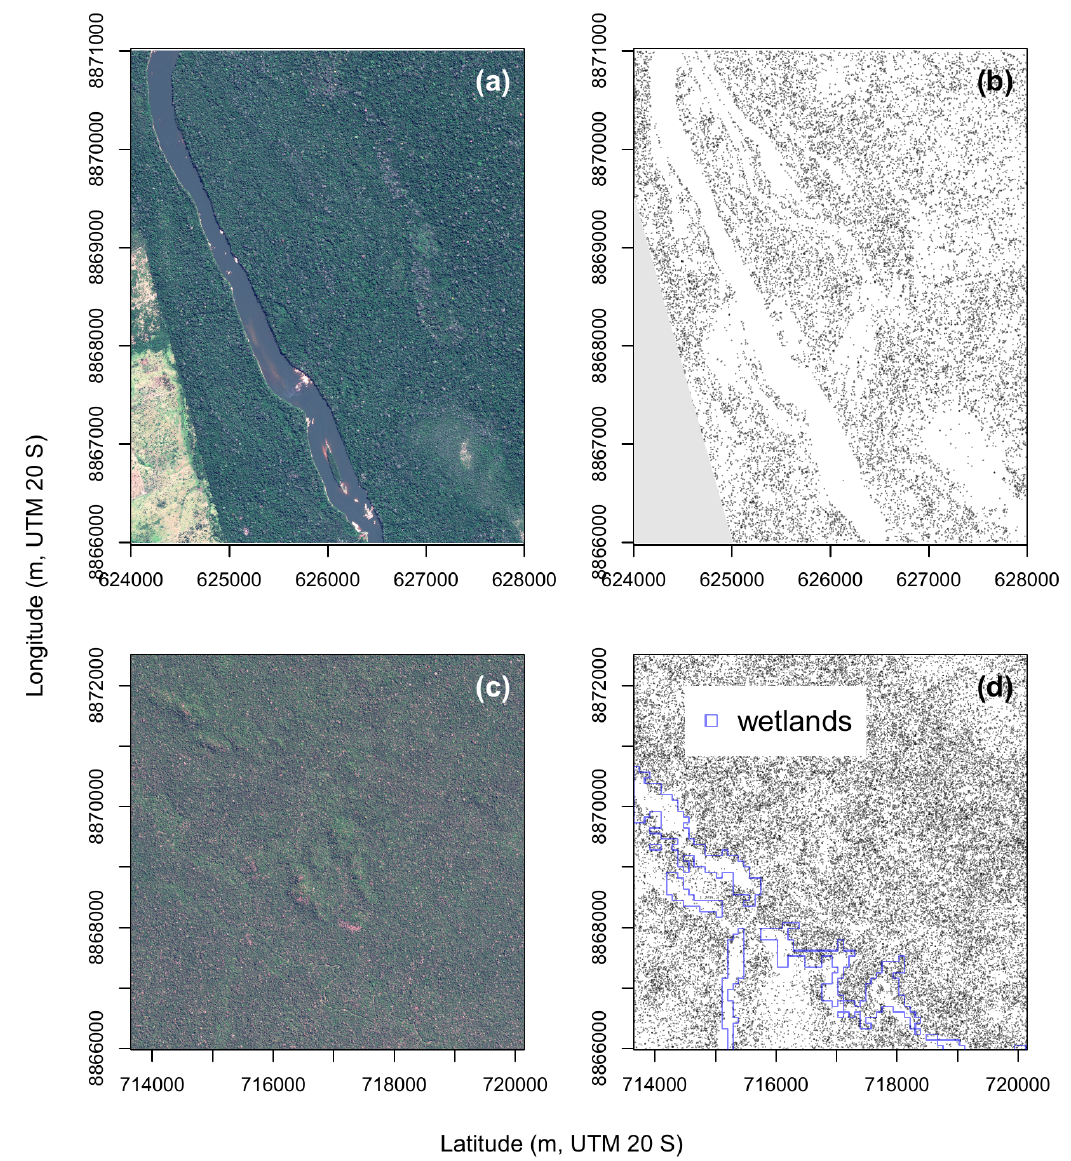
Figure 7. RGB image and natural distribution of canopy palms for two areas, near the river Ji-Paraná ( a , b ) and near the wetlands of the ’Igarapé Castanhal’ and ’Igarapé Curral da Vara’ rivers confluence ( c , d